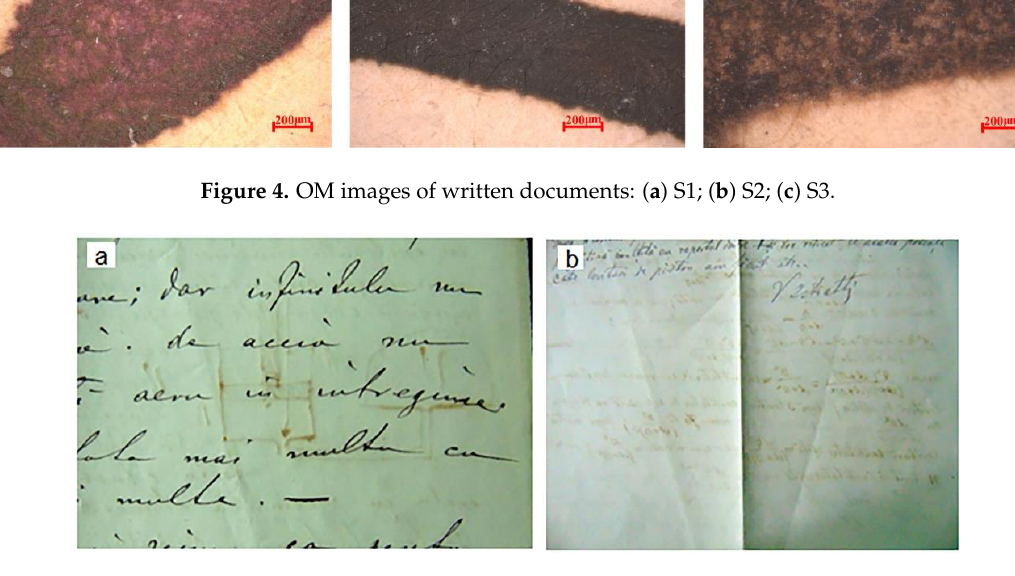
Ca and S in all the samples; in addition, the samples marked S2 and S3 also contained Mg, Na, Cl and P (Table Table 1. Elemental composition of the three documents.